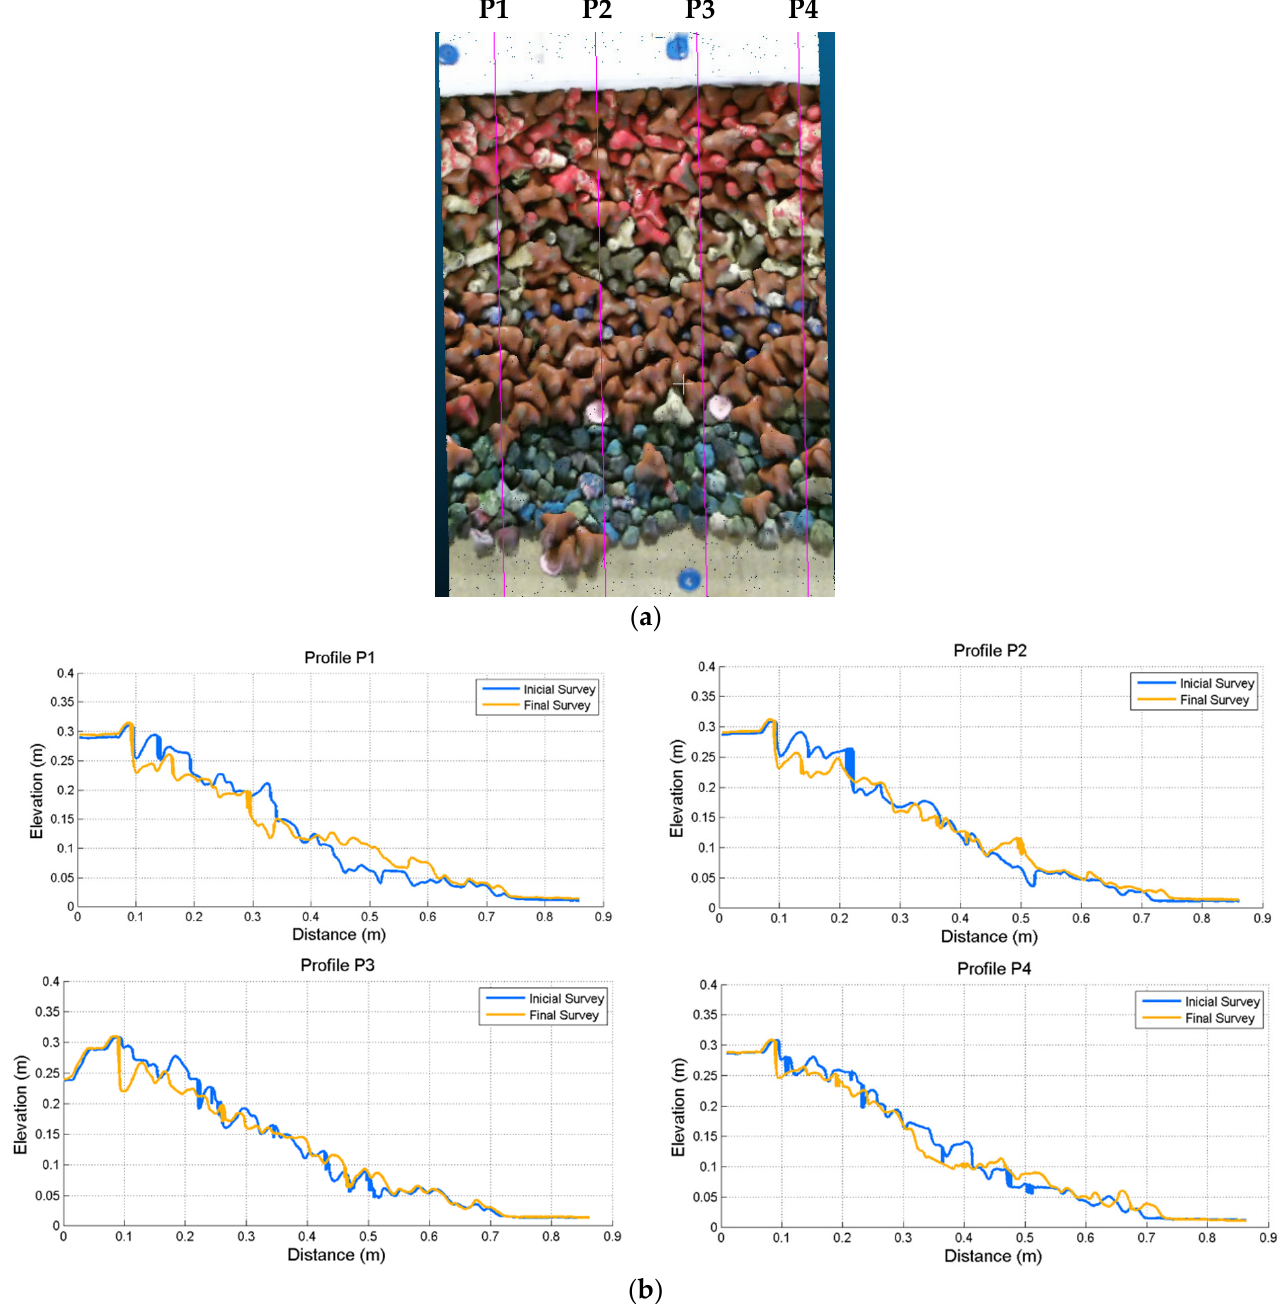
Figure 6. Profile P1 to P4. Profile location ( a ) and profile differences between initial and final survey ( b ).